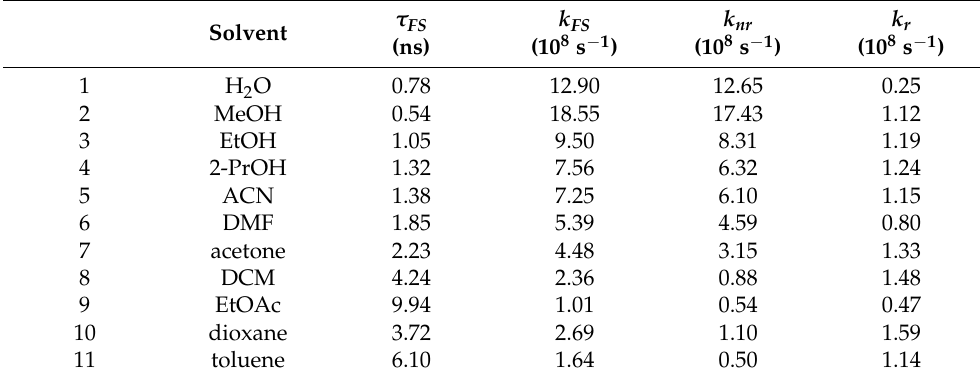
Table 1. Decay rate constants of compound 1 in 11